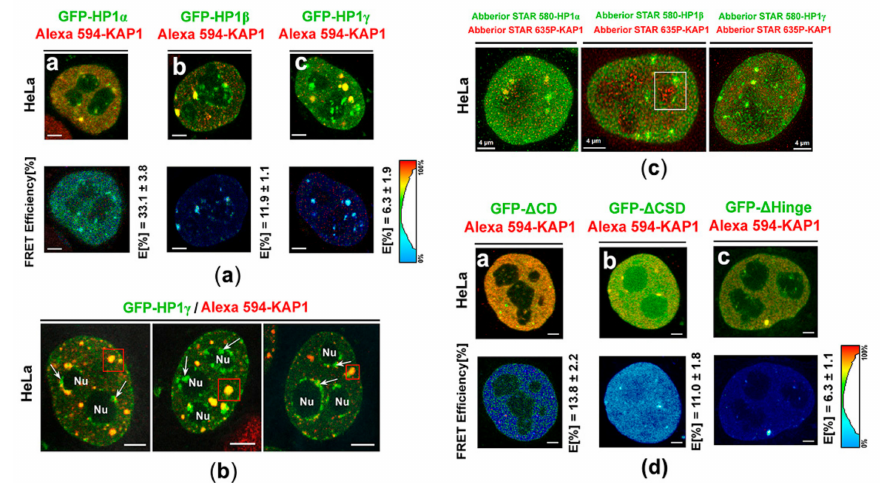
Figure 7. Fluorescence Lifetime Imaging-Forster Resonance Energy Transfer (FLIM-FRET) analysis of potential interaction between heterochromatin protein 1 (HP1) protein isoforms and the KAP1 protein. ( a ) Analysis of a GFP-tagged HP1 α -KAP1, b] GFP-tagged HP1 β -KAP1, and c] GFP-tagged HP1 γ -KAP1. ( b ) An example of a nuclear distribution of HP1 γ and the KAP1 protein. HP1 γ -positive regions of nucleoli (green) were absent of KAP1. Abbreviation Nu means nucleoli; arrows show HP1 γ foci absent of KAP1 and red frames show HP1 γ foci colocalizing with KAP1. ( c ) Example of STED analysis showing the location of KAP1 inside the cell nucleoli decorated by the HP1 isoforms (see HP1 β in white frame). ( d ) FLIM-FRET analysis of a] GFP-tagged HP1 β ∆ CD / Alexa 594-KAP1, b] GFP-tagged HP1 β ∆ CSD / Alexa 594-KAP1, and c] GFP-tagged HP1 β ∆ Hinge / Alexa 594-KAP1. E [%] means FLIM-FRET e ffi ciency. Scale bars represent 4 µ